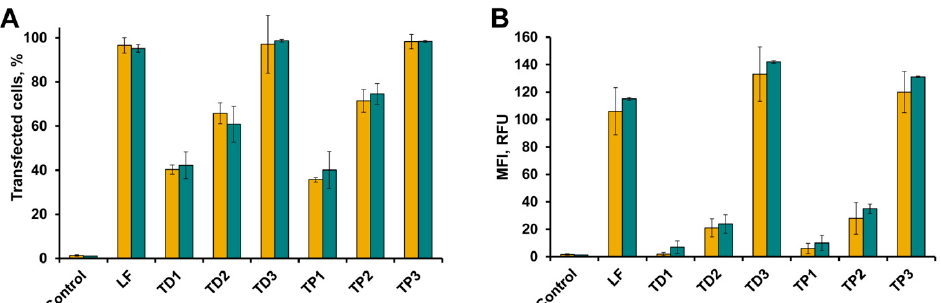
Figure 4. Intracellular accumulation of FAM-labeled transport oligonucleotides into A549 (yellow bars) and HEK293 (green bars) cells. The percentage of fluorescent cells ( A ) and mean fluorescence intensity ( B ) were measured using flow cytometry 4 h post transfection. LF = transfection of FAM-ON-PO mediated by Lipofectamine 2000. Data presented as MEAN ± SD.